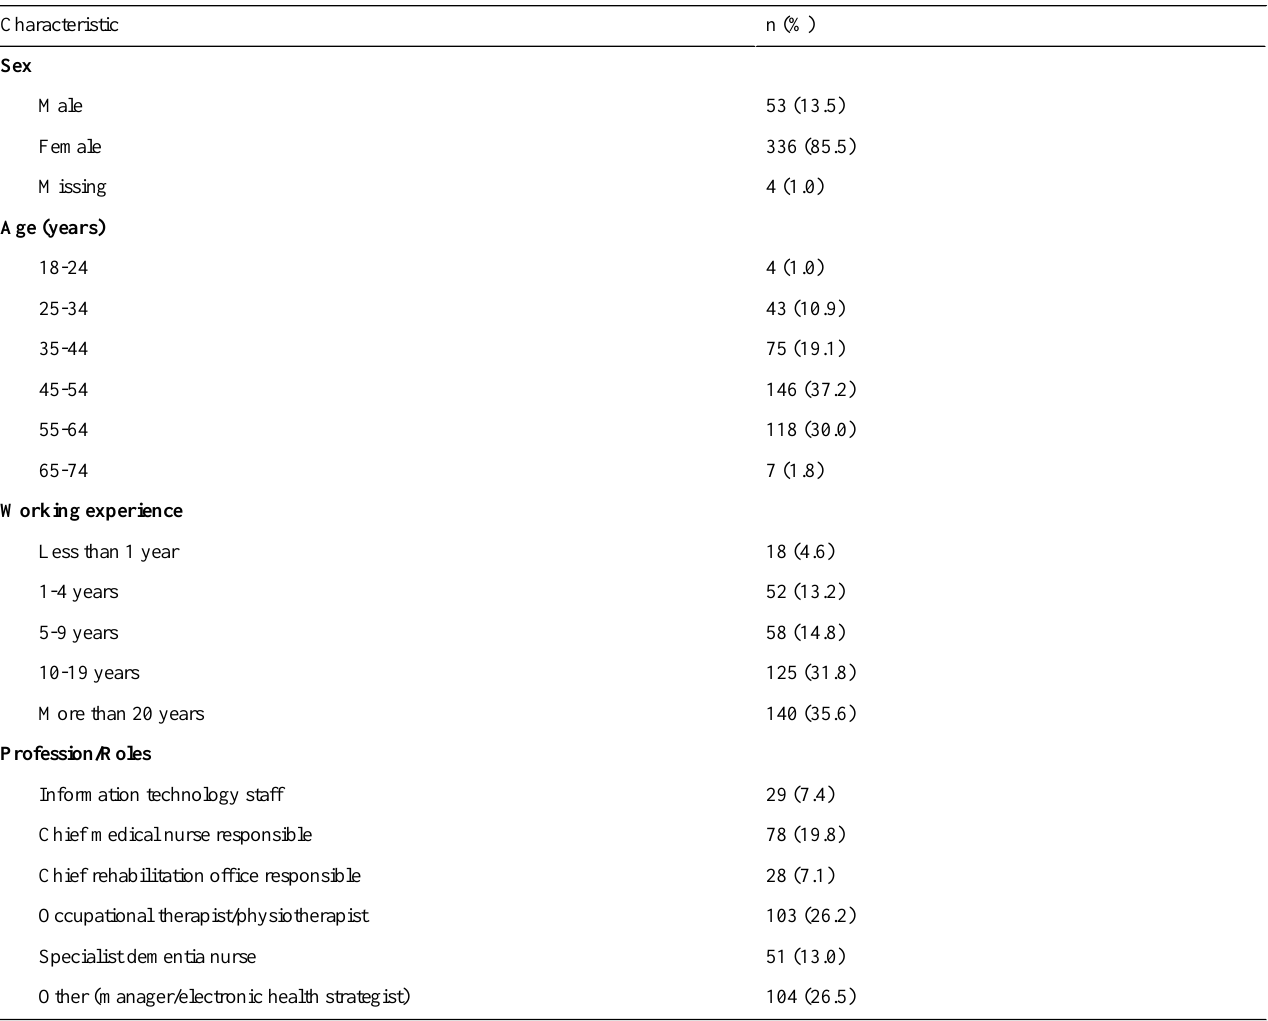
Table 1. Characteristics of the study population